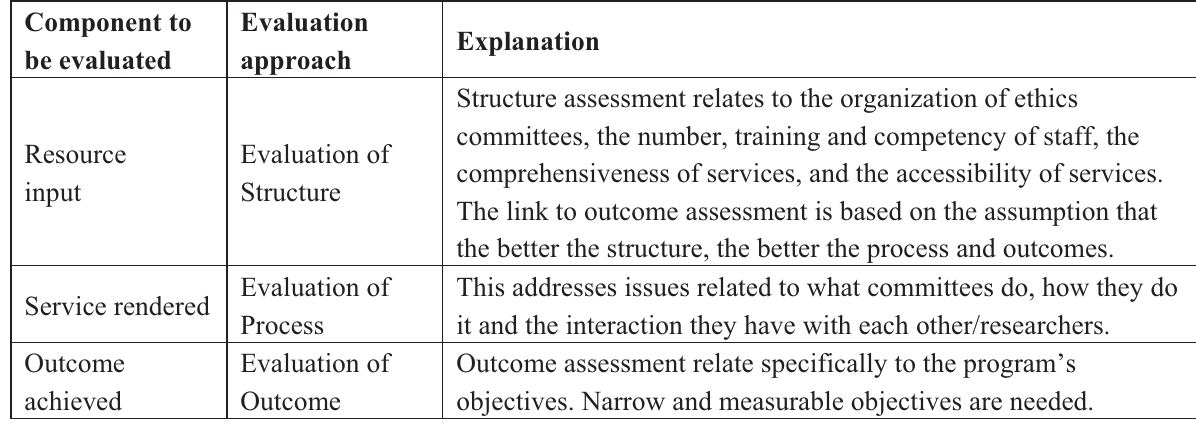
Table 1. Donabedian’ structure-process-outcome model (adapted from [8] about the three types of administrative evaluations).